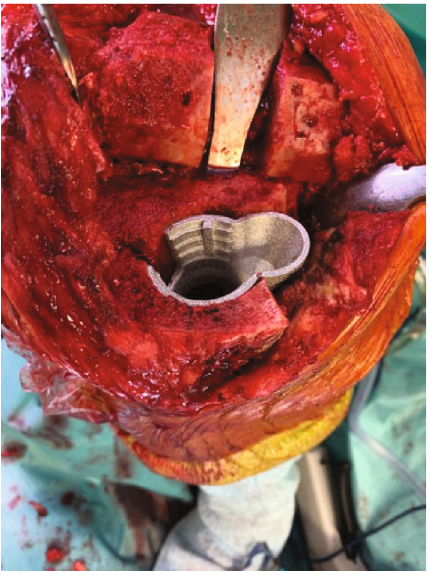
Figure 2: Intraoperative situation after insertion of the